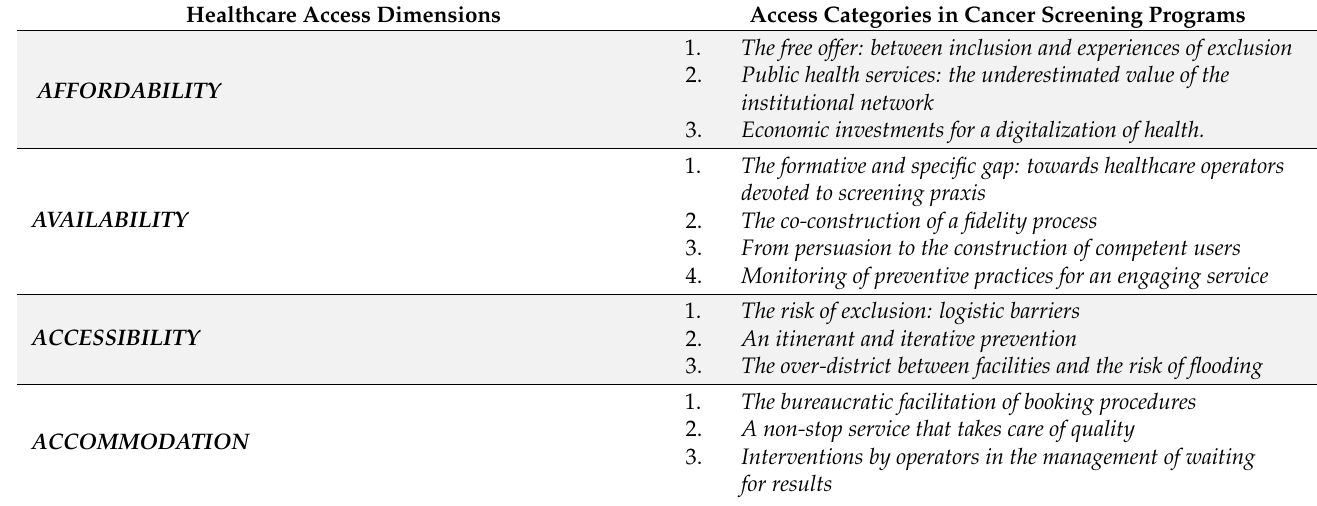
Table 1. Healthcare access dimensions and access categories in cancer screening